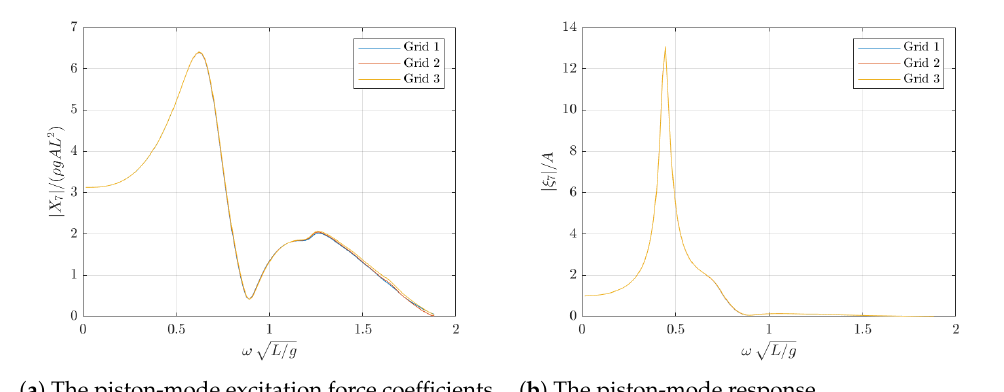
Figure 15. Convergence of the WAMIT piston-mode excitation forces and motion response for three grid resolutions.